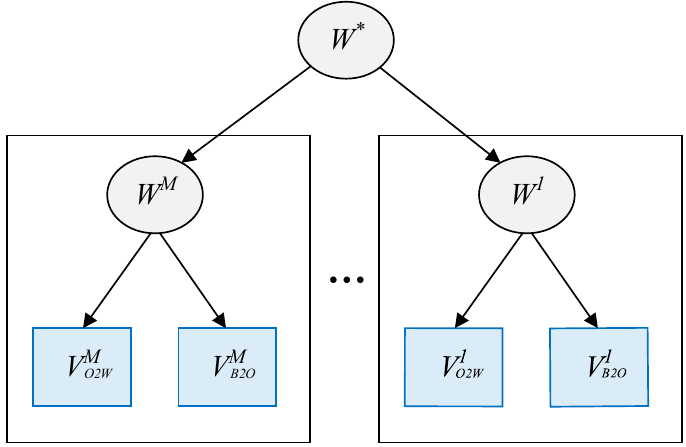
Figure 5. Graphical illustration of the probabilistic model of the Bayesian BWM.